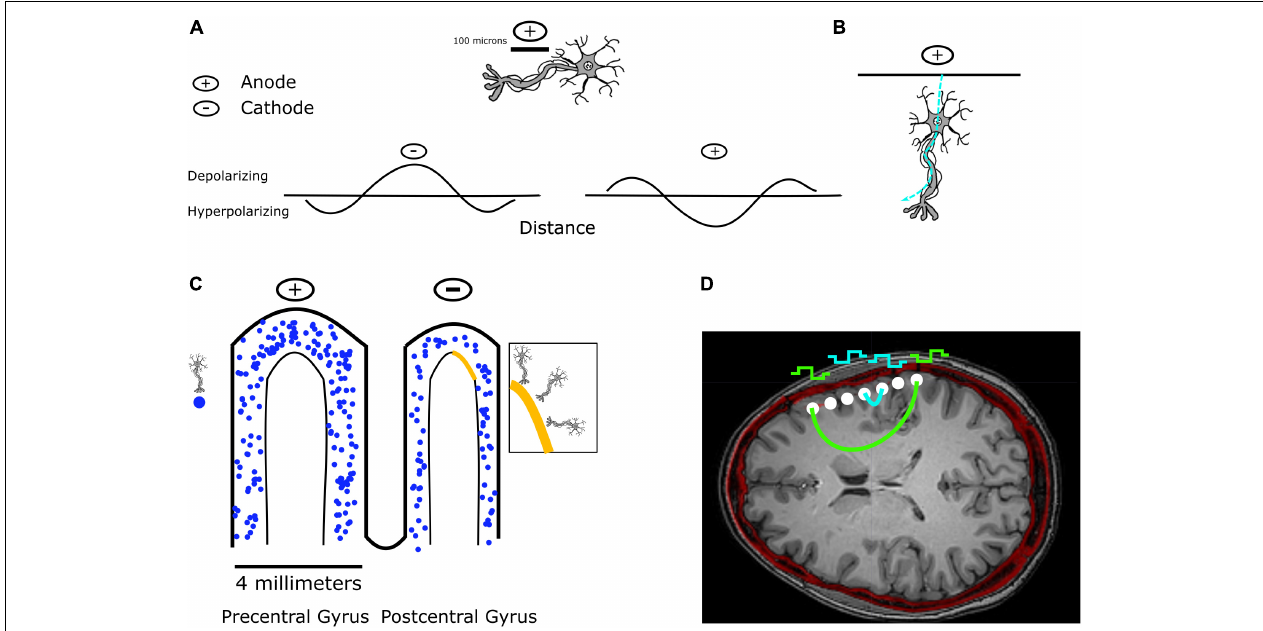
FIGURE 1 | Effect of stimulation on a single neuron and on a population of neurons. (A) Stimulation along a nerve fiber results in depolarization beneath the cathode, and hyperpolarization beneath an anode. (B) Single neurons can be stimulated by both anodal and cathodal stimulation depending on their orientation. In this example, anodal current enters the dendrites of the neuron and leaves through the axon, which results in depolarization of the axon and an action potential. (C) In the case of stimulation through ECoG electrodes, a large population of neurons can be activated by stimulation. Shown are approximate scales of an ECoG electrode relative to the precentral and postcentral gyrus, along with a representative mixed population of pyramidal neurons potentially depolarized by stimulation. In the zoomed-in region, we highlight the multiple orientations of neurons that could be activated. (D) An axial slice in a co-registered CT and MRI image following implantation with an ECoG array shows the potential current paths that different stimulation configurations would have to pass through, illustrating the large populations of neurons present within the potential current path. (A,B) Inspired by Ranck